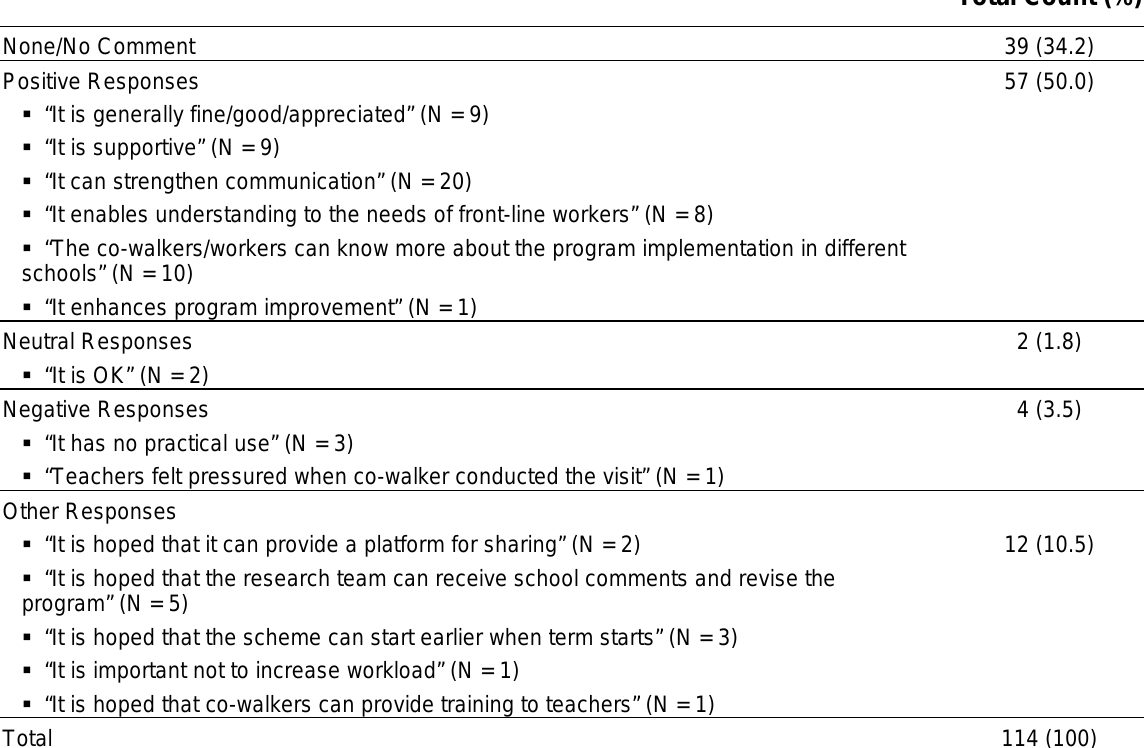
Workers’ Perceptions of the “Co-Walker Scheme” (Secondary 1